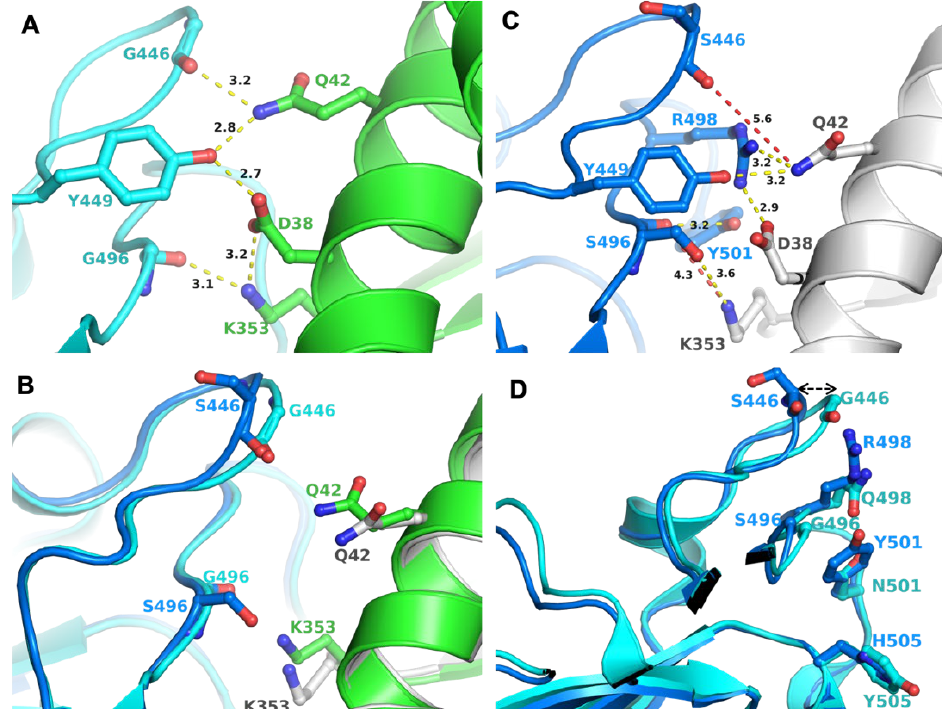
Figure 1. Interactions between S-RBD and ACE2 and impact of mutations. ( A ) Panel A shows the interaction network between S-RBD and ACE2, created by G446 and G449 (as in BA.2); the two residue positions that reverted to WT sequence in BA.2 compared to BA.1, which has S446 and S496, respectively. Figure generated from PDB entry 6M0J [13]. The amino acid residues are shown in the ball-and-sticks representation. The S-RBD is in cyan and ACE2, in green. The carbon atoms are rendered in the same color as the molecule (S-RBD or ACE2). In this and subsequent panels and figures, oxygen atoms are red and nitrogen atoms are blue. All distances in this and in subsequent figures are in Å. ( B ) Panel B shows the conformational change in the loops containing G/S446 and G/S496. WT-like S-RBD is in cyan and BA.1 S-RBD is in teal. ACE2 of WT S-RBD is in green and that of BA.1 is in gray. ( C ) Panel C shows that Mutation G446S and G496S (as in BA.1). These mutations cause a conformational change of the loop comprising 446 and 496 positions. Figure generated from PDB entry 7T9K, representing the BA.1 S-RBD/ACE2 complex [14]. ( D ) Panel D shows common mutations (except S446 in BA.1 and G446 in BA.2) lined at the interaction surface of S-RBD and ACE2. The color code for molecules is the same as in Panel C.